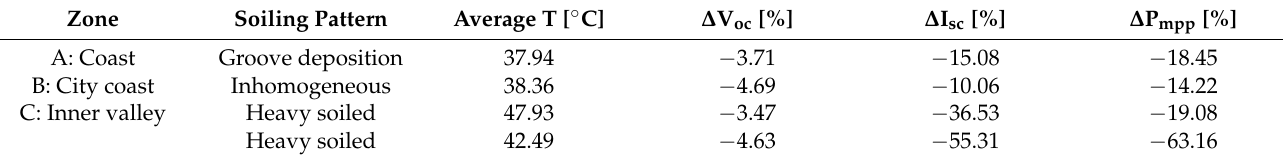
Table 3. Average variation of electrical parameters of heavily soiled